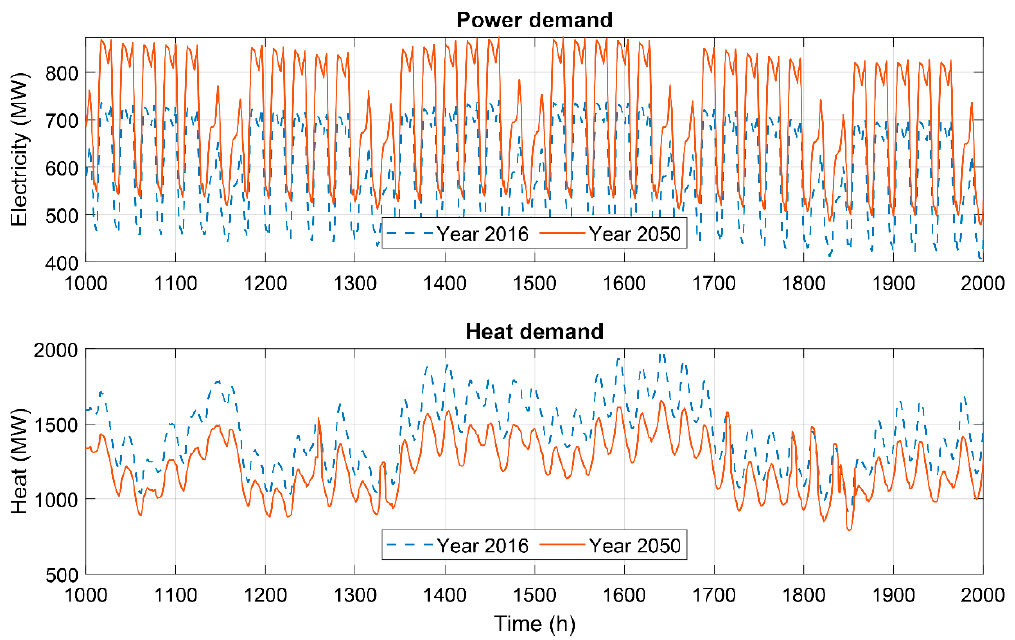
Figure A1. Power and heat consumption for Helsinki (2016 and 2050). Table A1. Renewable energy potentials in the national case. The potentials are based on Reference [47], with the exception of wind power (50 GW, [54]).